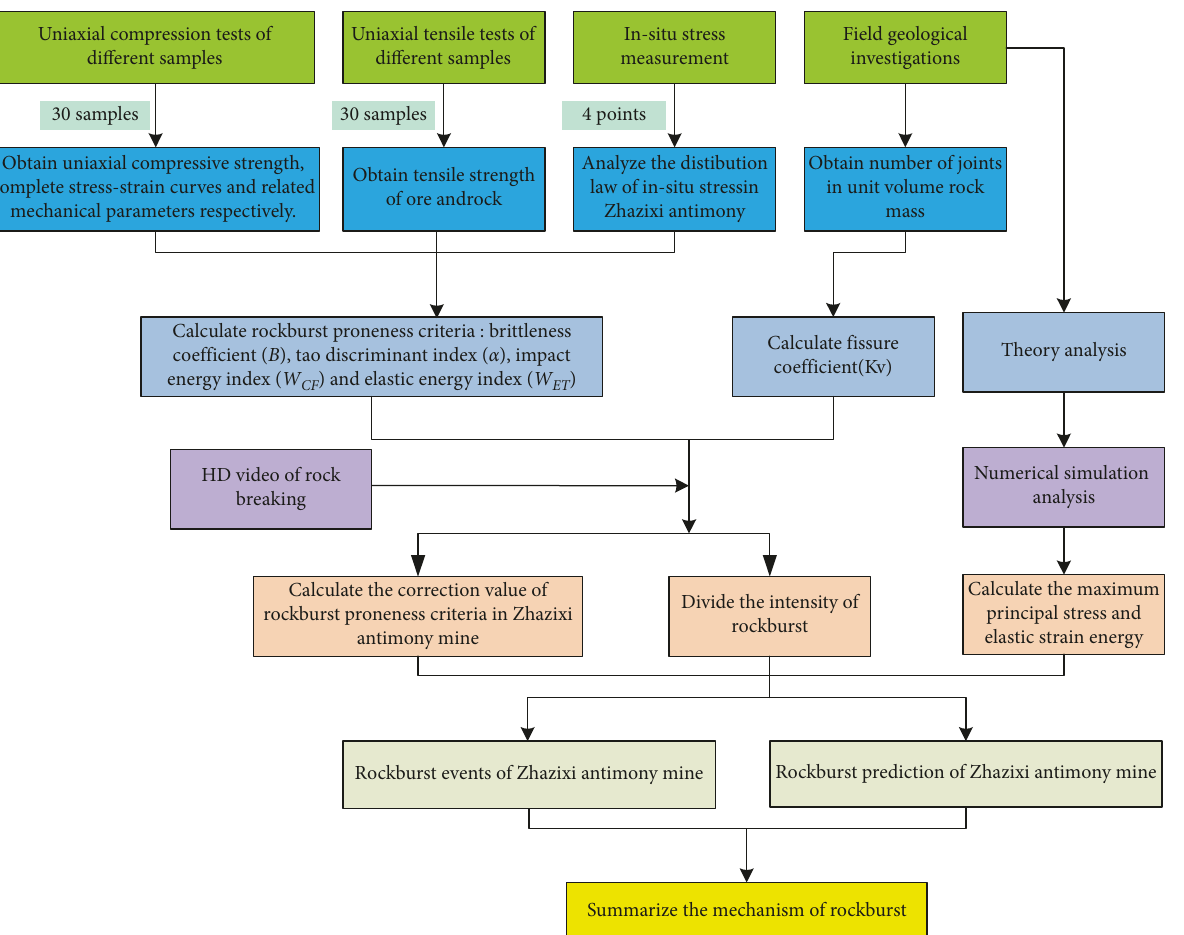
Figure 4: The block diagram of rockburst mechanism in Zhazixi Antimony